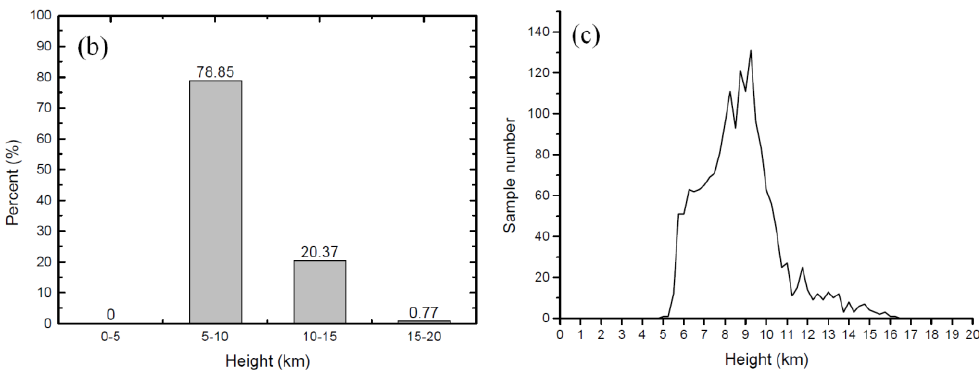
Figure 5. ( a ) Horizontal distributions of convective storm top altitudes (units: km); ( b ) Percentage of different convective storm top altitudes; ( c ) Distribution of convective storm top altitudes, among the samples.